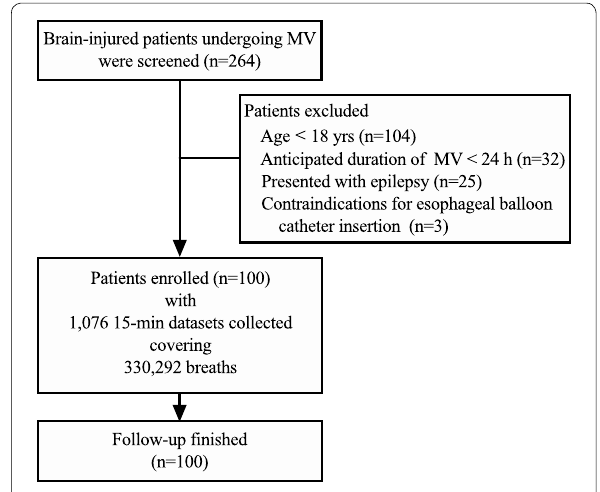
Fig. 1 Patients flow‑chart